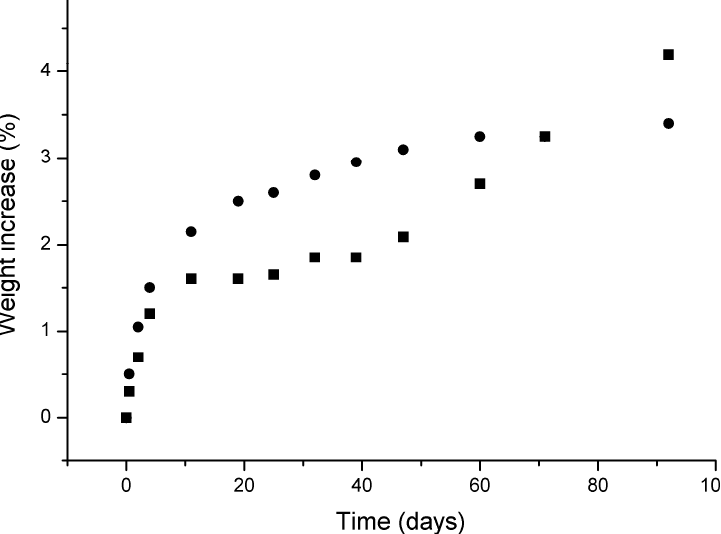
Figure 4. Kinetics of rehydration in humid air of completely (squares) and partly (to the degree of 50%, circles) dehydrated elpidite from